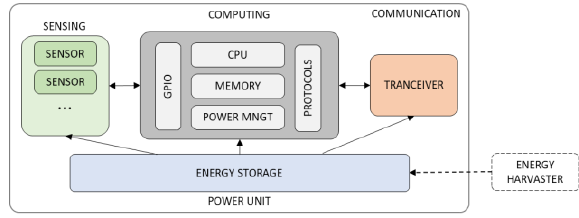
Figure 2. IoT Sensor Device block diagram